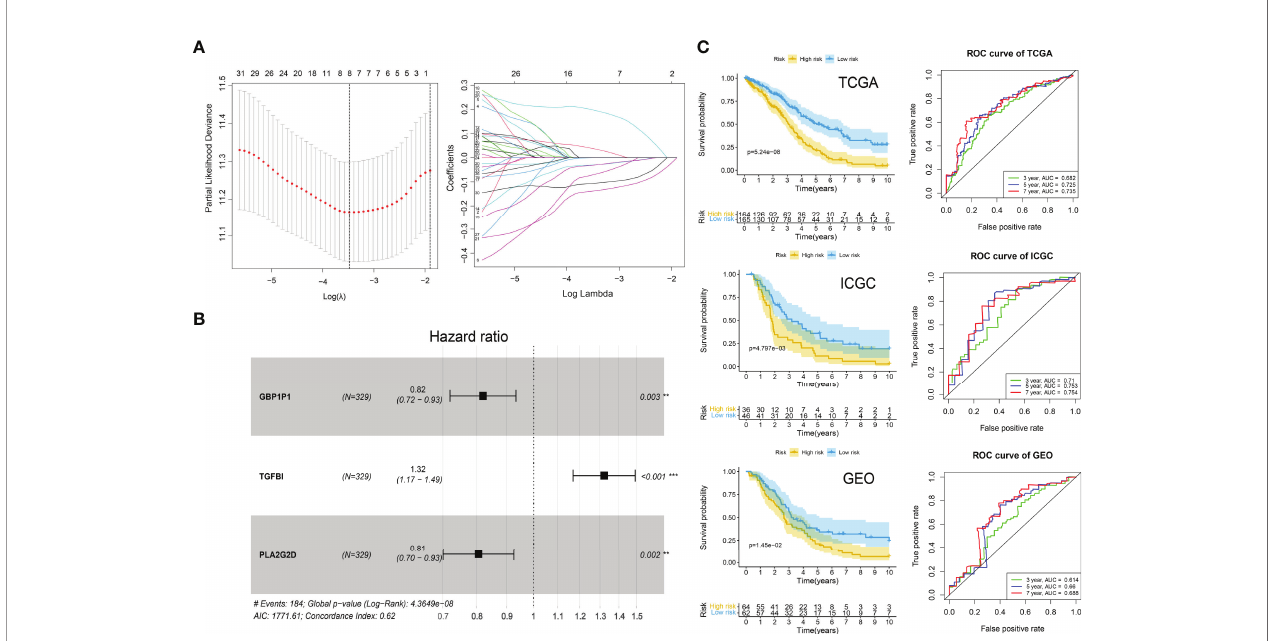
FIGURE 7 | ICI gene signature for survival prediction. (A) Lasso regression analysis. Partial likelihood deviance pro fi les (left). Coef fi cients pro fi les (right). (B) Hazard ratio of multivariate Cox model. ** P < 0.01; *** P < 0.001. (C) Kaplan-Meier curves (left) of high-risk and low-risk groups and ROC curves (right) in TCGA, ICGA, and GEO cohorts. Log-rank